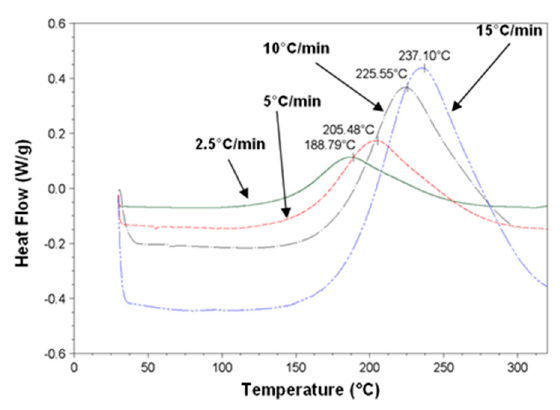
Figure 7. DSC analyses on reactive epoxy/amine (E/A) systems for different heating rates.